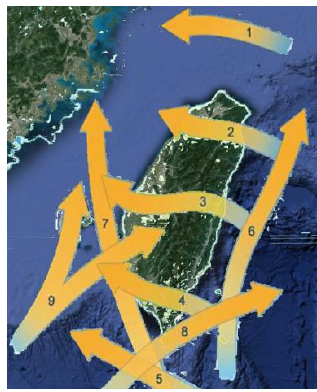
Figure 5. Nine categories of typhoon tracks classified by the Central Weather Bureau of Taiwan. Table 1. Number of typhoon events corresponding to each category during the period 1978–2017. Category Count